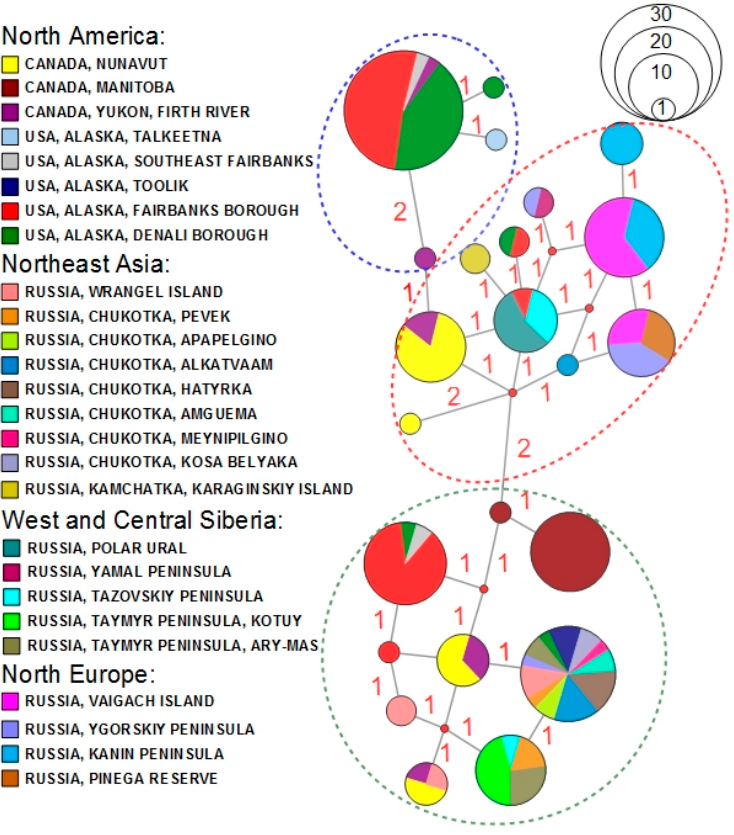
Figure 3. Phylogeography of Pterostichus brevicornis brevicornis. Median-joining network of COI sequences (see Supplementary Materials Table S1 for details). Colours match locations in the legend and mutations are shown as red numbers at the branches. The dashed ellipses correspond to subclades of the phylogenetic tree (see Figure 2). The relationship between circle size and number of specimens is shown in the upper right corner. Table 2. Genetic diversity indices of Pterostichus brevicornis brevicornis samples based on COI se- quences.